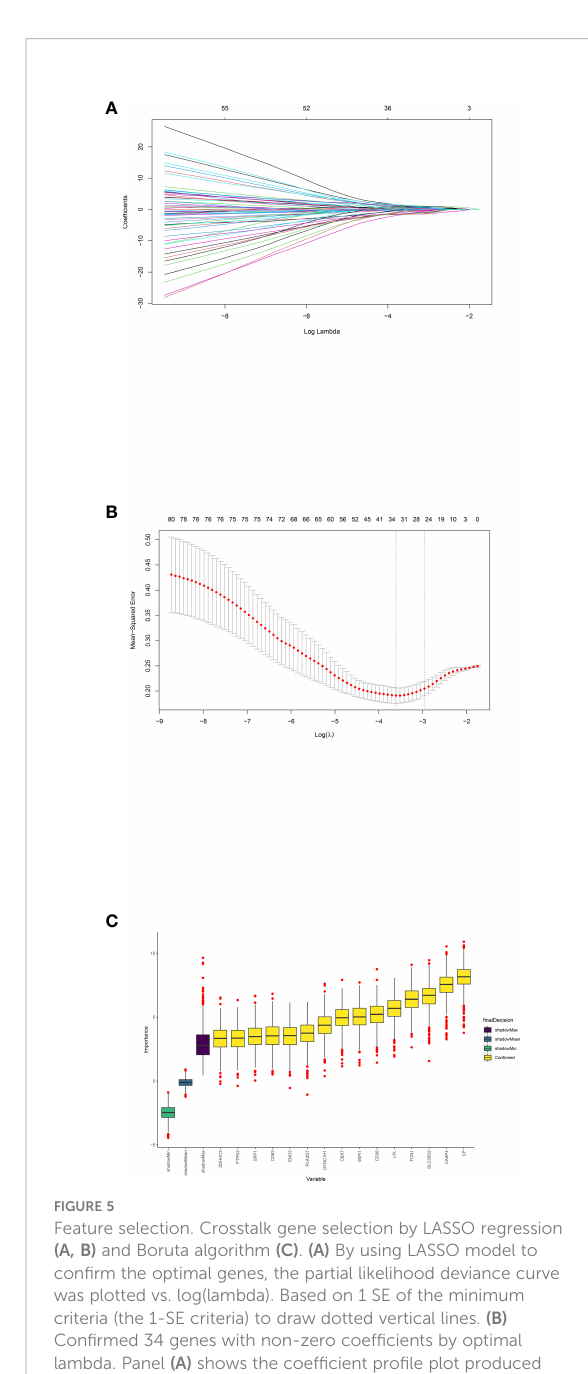
FIGURE 4 The protein – protein interaction analysis. (A) The PPI network analysis of the 80 common DEGs. (B) The hub genes identi fi ed by CytoHubba.